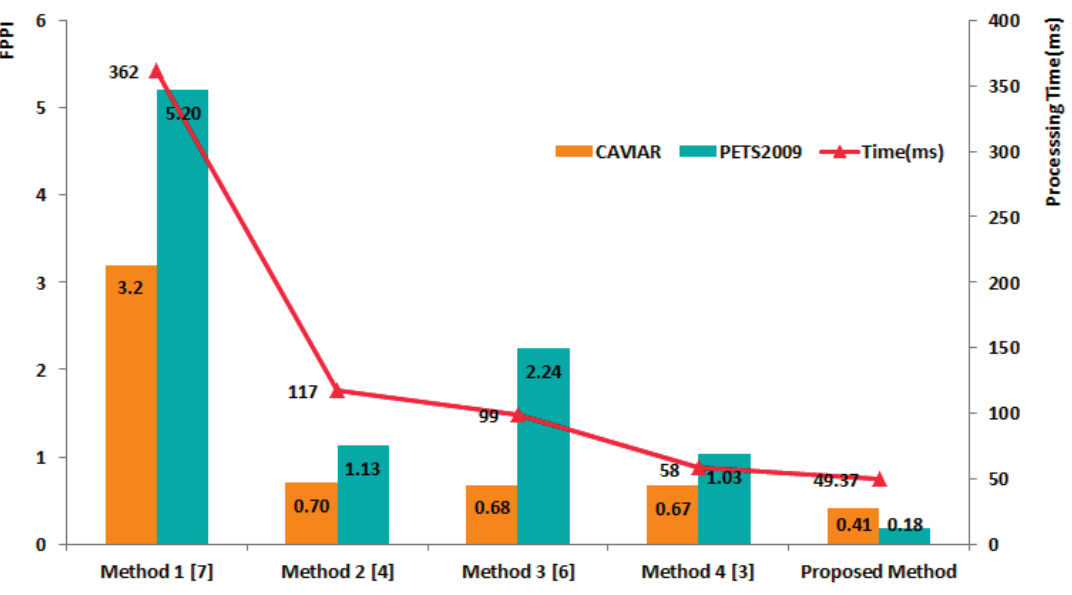
Figure 5. Performance comparison of FPPI and the computational time for the proposed method versus four other methods using different image-scaling techniques. The average FPPIs and recall of the detection results for Methods 2 and 3 were performed in the same condition of [4] and [6]. For Method 1, we used the source code of OpenCV. In addition, we used the open-source of Benenson et al . [3] for method